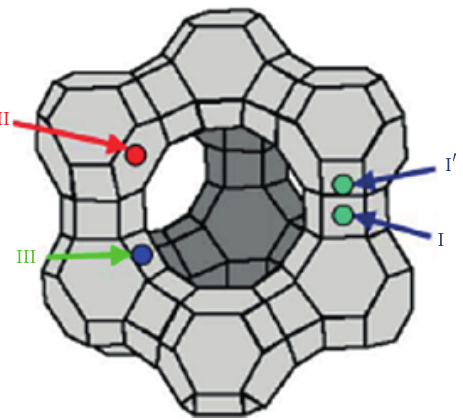
Figure 1: Structure of the NaX zeolite framework and description of the main crystallographic sites for the extraframework cations.